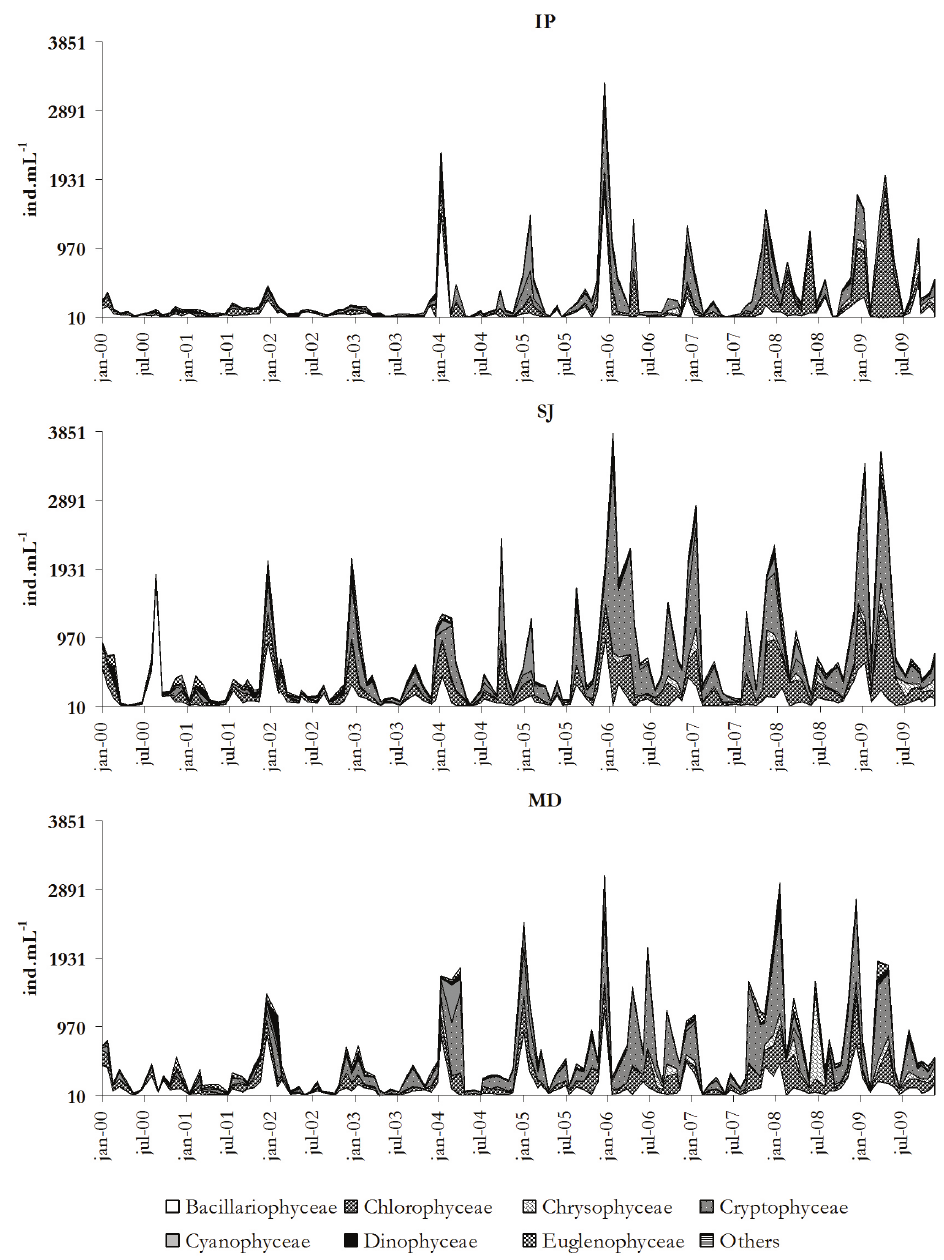
Figure 3. Temporal profile of density classes of phytoplankton in Guaiba